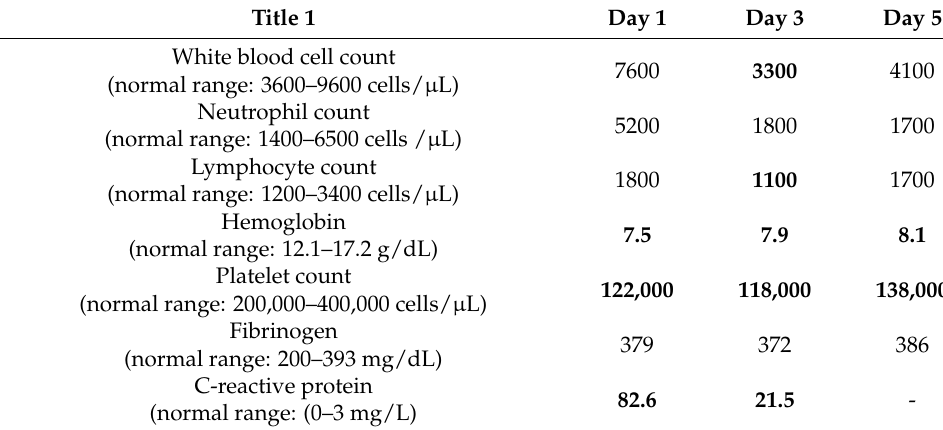
Table 1. Laboratory workup for Case